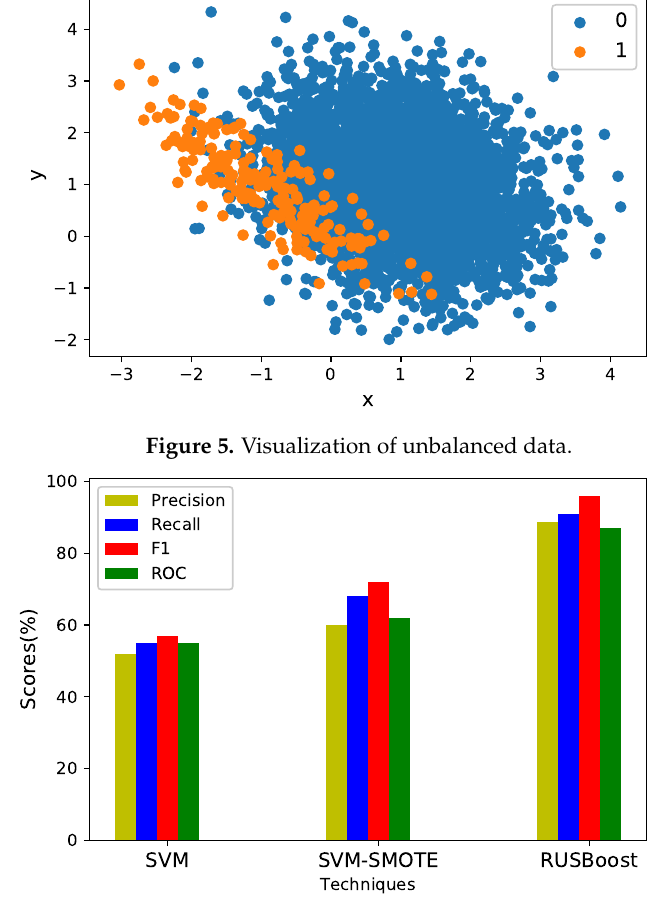
Figure 6. Performance comparison of balanced and unbalanced